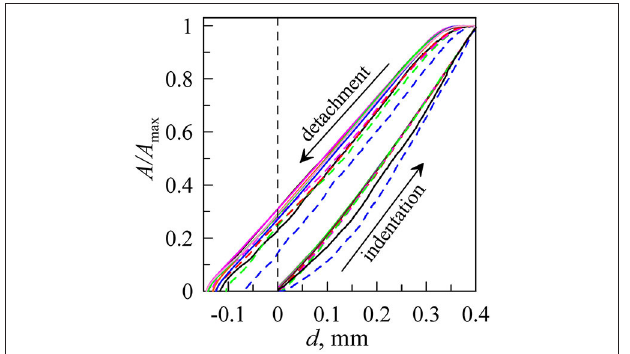
FIGURE 10 | Dependencies of normalized contact area A / A max vs. indentation depth d at indentation and detachment processes for different types of roughness of indenter with radius R = 40mm. The lines correspond to the different values of the sandpaper (see Figure 5 ).